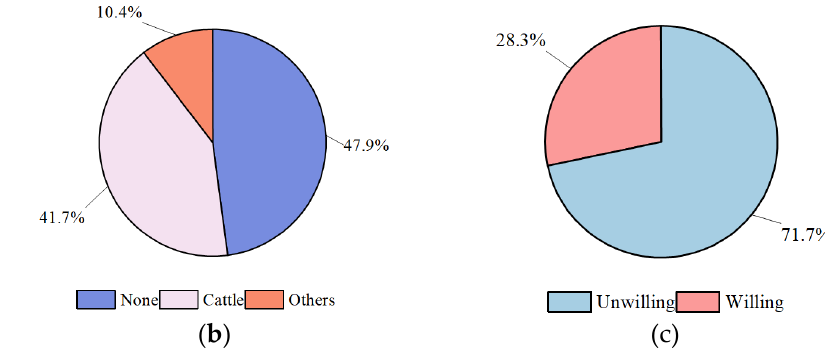
Figure 4. Farmers’ willingness structure. ( a ) Willingness to plant; ( b ) Willingness to breed; ( c ) Will- ingness to rural tourism development.